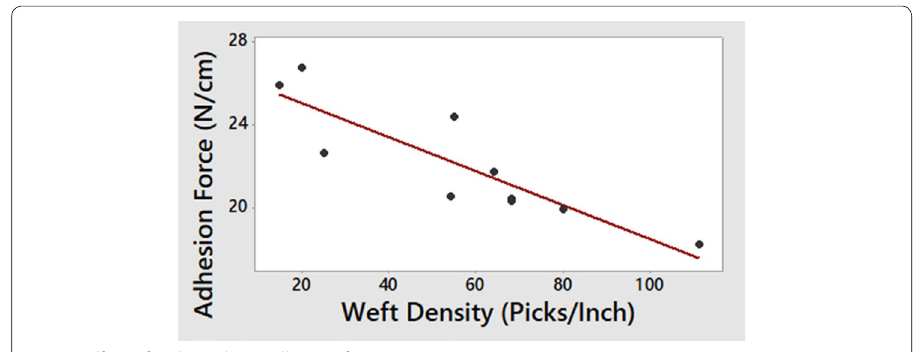
Fig. 6 Effect of picks/inch on adhesion